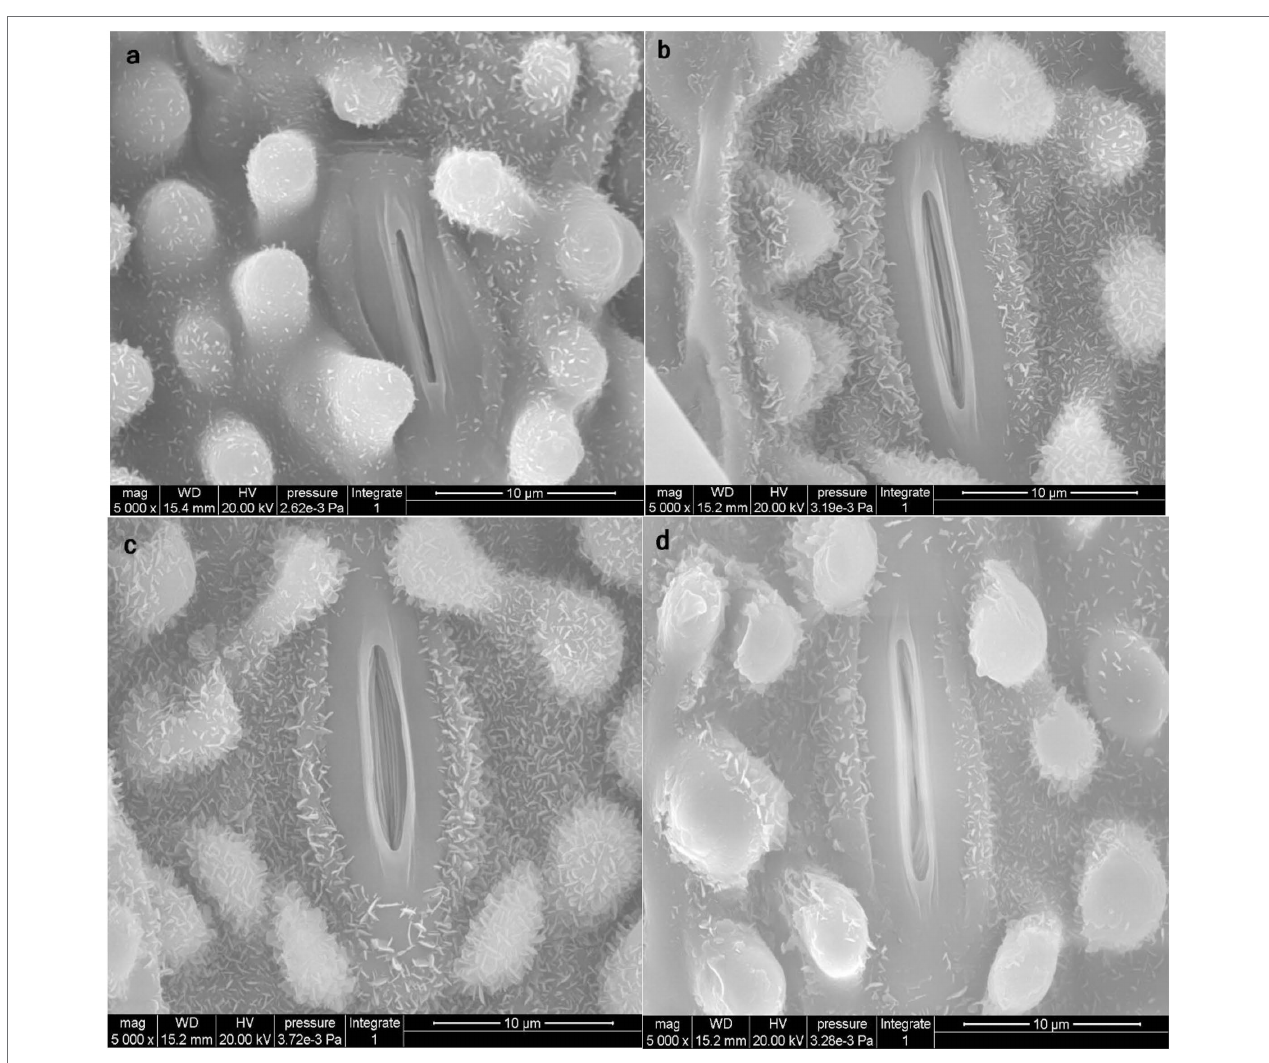
FIGURE 6 | Scanning electron microscopy (SEM) images of stomata closure (opening and closing of stomata) on the leaf surface of bamboo ( Pleioblastus pygmaea ). Image (a) displays the control treatment under normal conditions. Image (b) displays the condition of stomata in plants receiving 200 μ M ZnO-NPs treatment. Images (c,d) display the condition of stomata receiving 150 μ M As and 150 μ M Hg ( c = As, d = Hg) treatment in combination with 200 μ M ZnO-NPs. The results suggest that ZnO-NPs kept stomata open when combined with 150 μ M As and can also help maintain stomata in a semi open and closed state when combined with 150 μ M